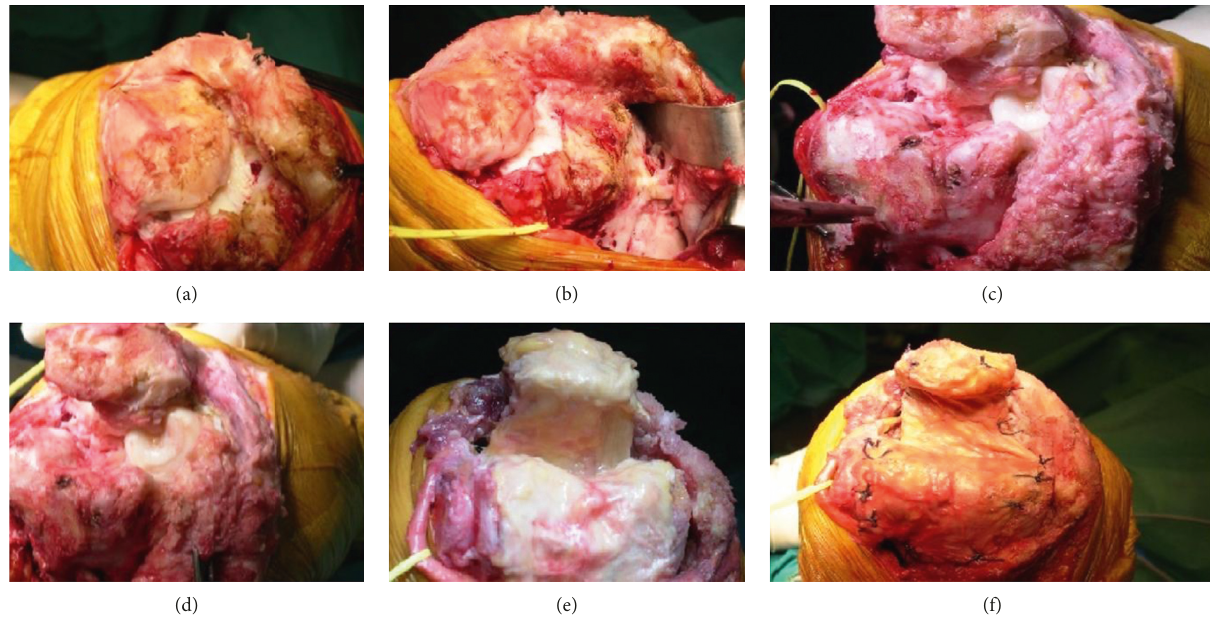
Figure 1: Peroperative situation. Posterior arthrotomy (a); marking and preservation of the ulnar nerve (yellow loop) (b); debridement of the ulnohumeral joint (c, d); good cartilage quality on the radial head (d); debrided ulnohumeral joint (e); interposition arthroplasty with sutured fascia lata graft, like a waterfall